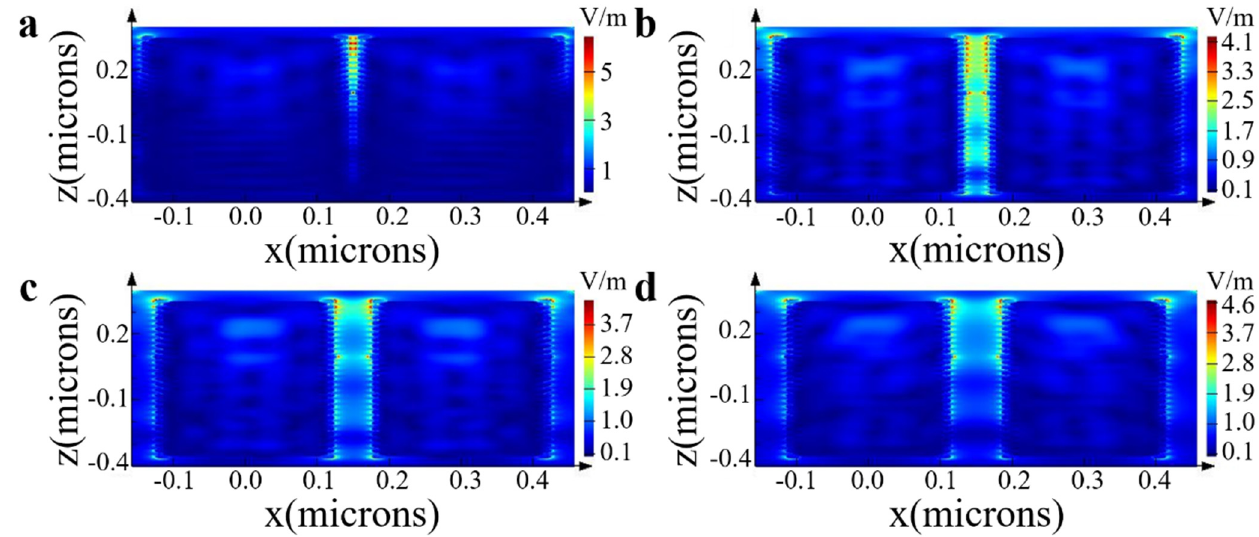
Figure 2. Distribution of the FDTD − simulated near − field electrical intensity in the wavelength of 785 nm with different SiNRs’ gap. ( a ) 30 nm, ( b ) 50 nm, ( c ) 70 nm and ( d ) 90 nm.